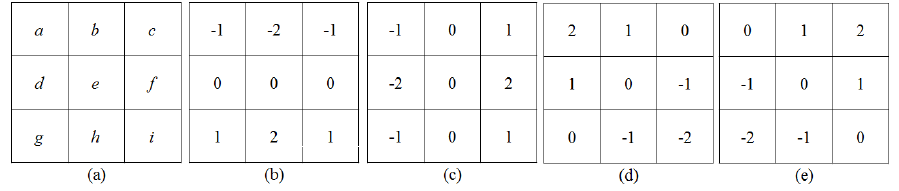
Figure 5. Sobel filters among different directions. ( a ) an example of original pixels for a 3 × 3 block within a CU. ( b ) a horizontal edge filter. ( c ) a vertical edge filter. ( d , e ) the extended filters for 45 ◦ and 135 ◦ ,